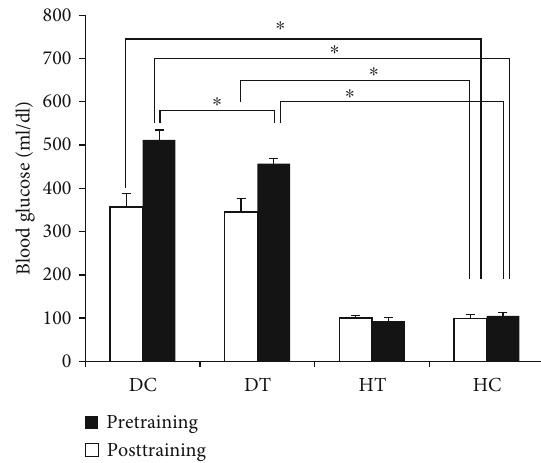
Figure 1: Changes of blood glucose after streptozotocin (STZ) injection (pretraining) and after 6-week exercise treatment (posttraining). The diabetic and trained group (DT) performed 6 weeks of endurance training. Data is shown as the mean ± SEM . ∗ P < 0 : 05 vs. control rats (two-way ANOVA). DC: diabetic control rats; DT: diabetic and trained; HC: health and control; HT: health and trained. Ten rats in each group were utilized for this